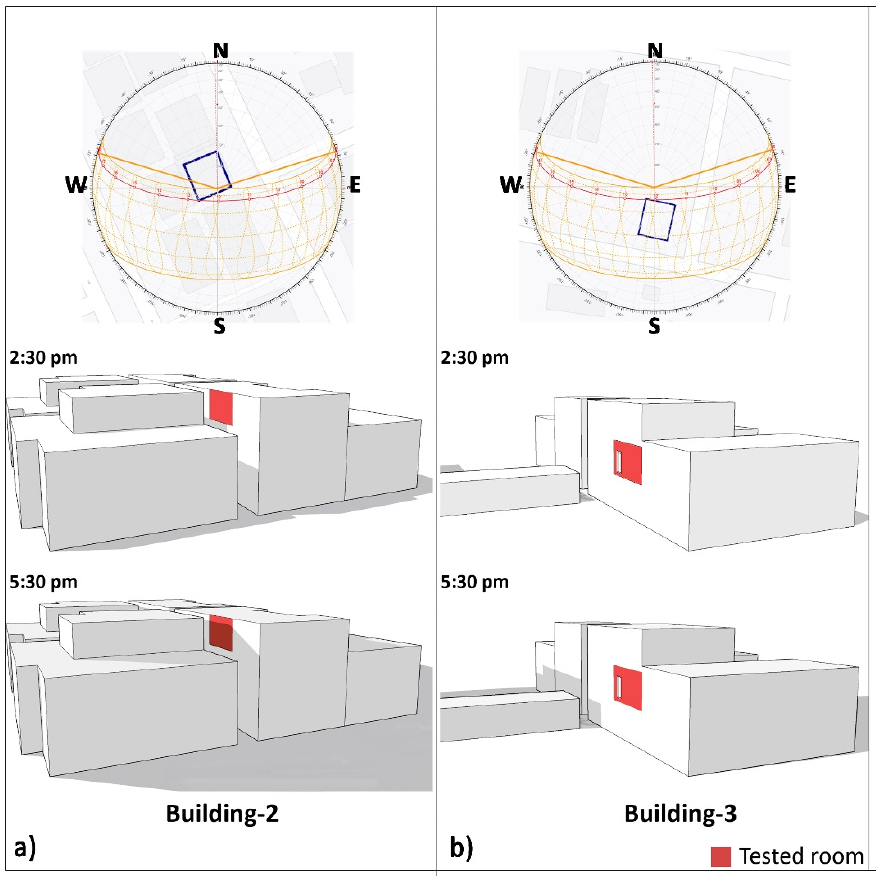
Figure 10. Orientation and shadow study of ( a ) Building ‐ 2 and (b) Building ‐ 3.